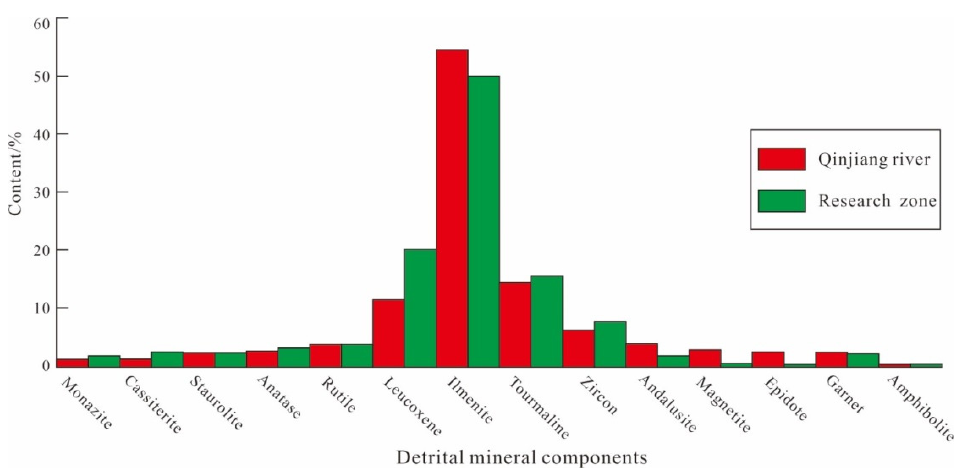
Figure 7. Comparison of terrestrial heavy mineral contents of surface sediments between outer Qinzhou Bay and the Qinjiang River.